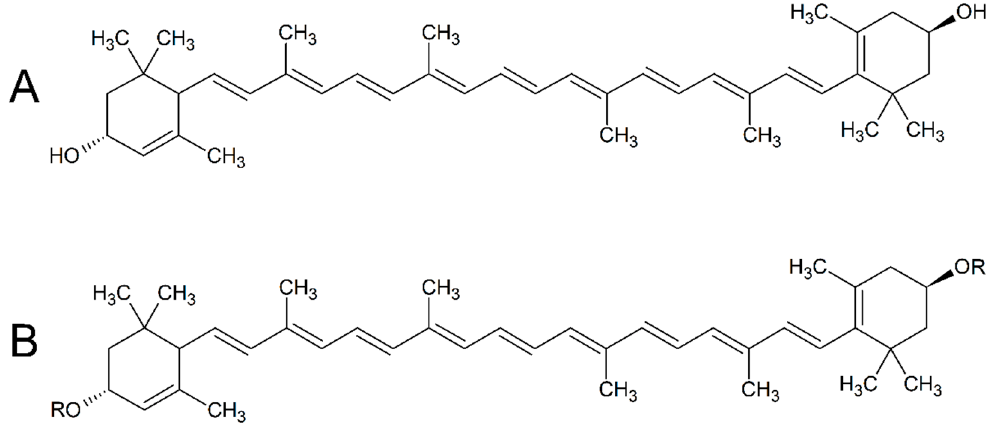
Figure 1. Structural formulae of lutein ( A ) and lutein esters ( B ) (common examples: R = palmitate, myristate, linoleate, laureate).